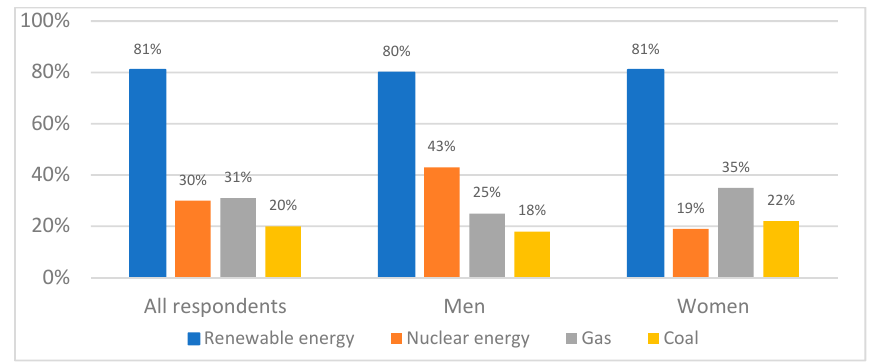
Figure 5. Preferred energy sources by consumers (by gender) in which Poland should invest.